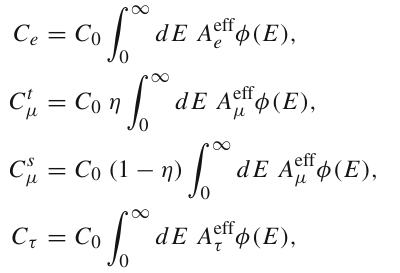
normalization at 100 TeV ( ∼ 30% for both HESE and TGM). The blue dotted line denotes the extrapolation to lower energies following the throughgoing muon shape. On the right panel we represent the product between flux and muon neutrino effective area, in arbitrary